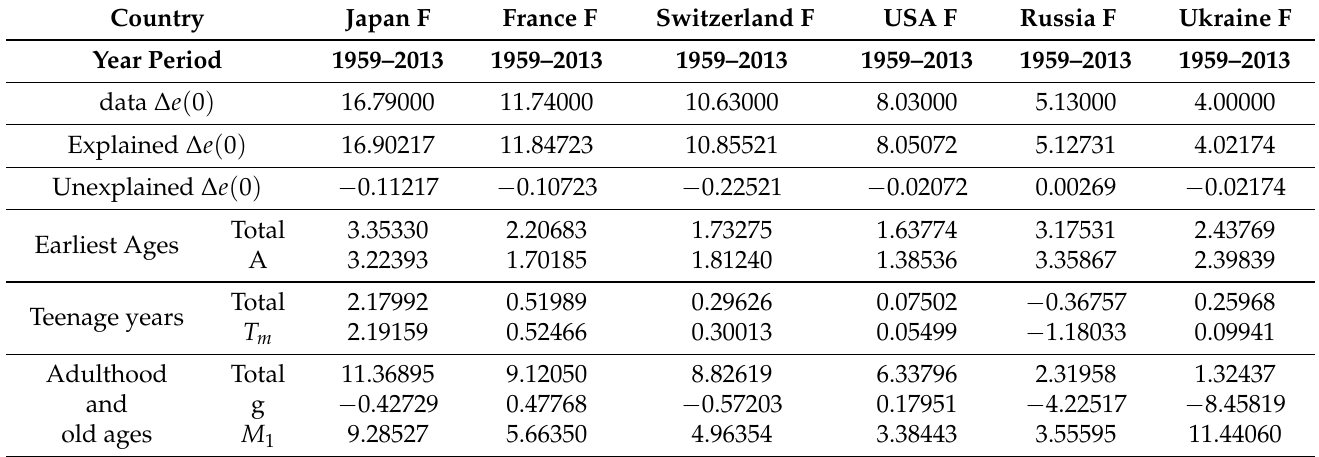
Table 13. Female life expectancy improvement quantitative analysis during years 1959 to 2013 for 6